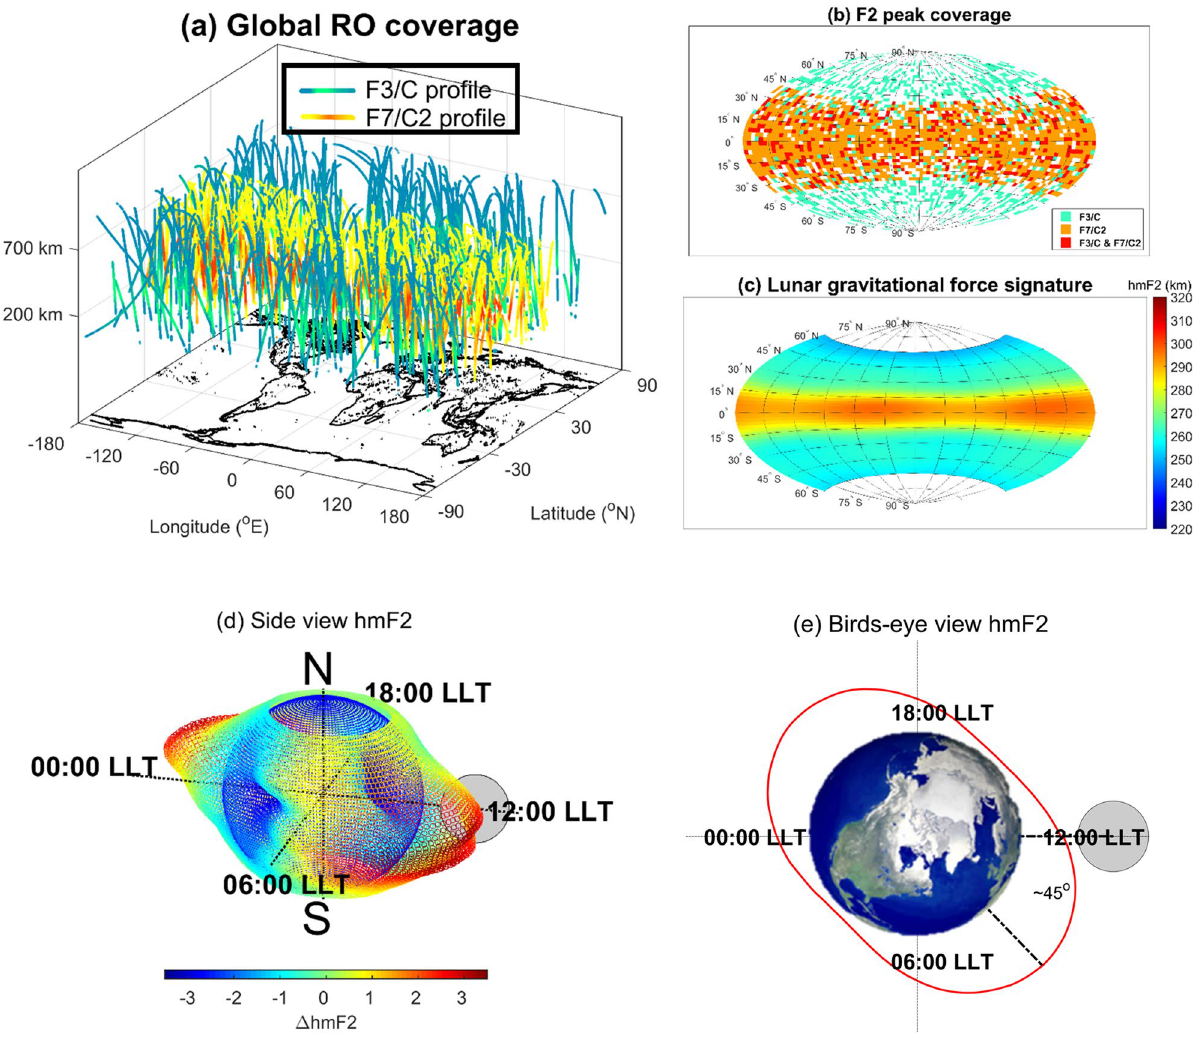
Figure 1. F3/C and F7/C2 ionospheric RO profiles. ( a ) Locations of daily F3/C and F7/C2 RO observations. ( b ) Locations of daily F3/C and F7/C2 F2-peak observations. ( c ) The global ionospheric F2-peak height (hmF2) on the magnetic latitude-lunar local time plane, as well as its ( d ) side-view (spherical view), and ( e ) birds-eye (equatorial plane) view over the entire 15-year composite. The red ellipse denotes the meridional averaged hmF2. The gray circle denotes the Moon position. The Global View of the Arctic Ocean is published by NASA/ JPL/ASF (https:// www. jpl. nasa. gov/ images/ pia02 970- global- view- of- the- arctic-